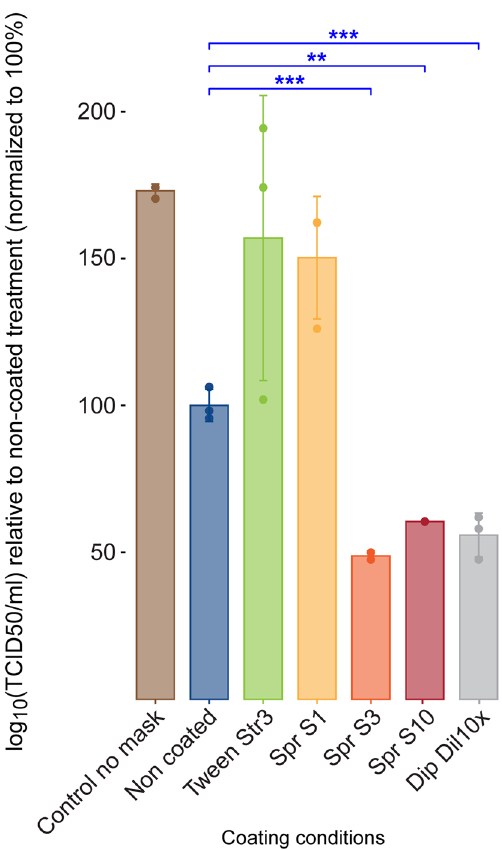
Figure 5. A/H3N2 virus titers in the apical medium of MUCILAIR epithelia infected after direct contact of the virus with a non-coated test material or test material coated with various concentrations of salt, determined at 72 h post infection. Data are expressed as a percentage relative to the mean of log 10 TCID 50 /mL in the infected non-coated treatment group, which was normalized to 100%. Means ± standard errors are shown; n = 3. ** P < 0.01; *** P <